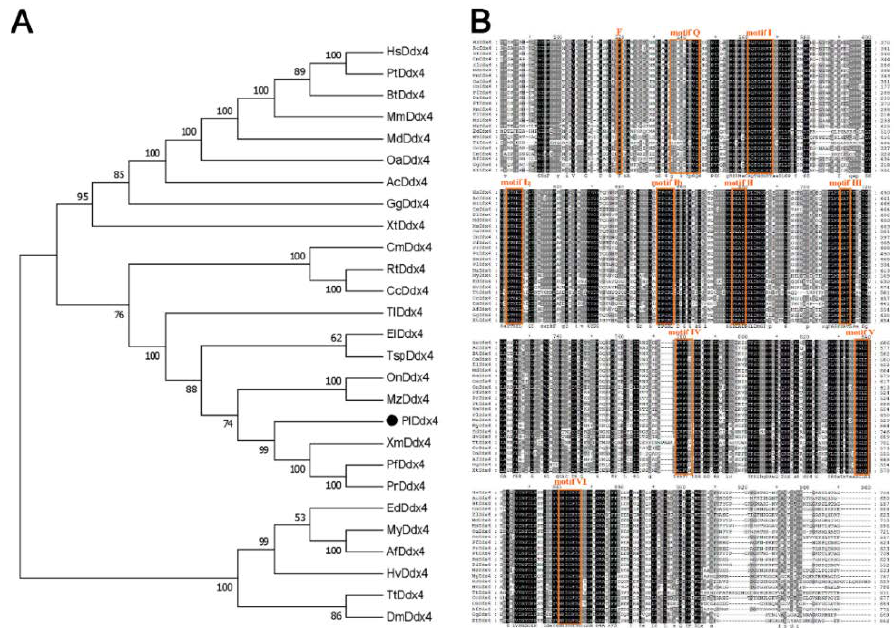
Figure 1. Sequence alignment and phylogenetic tree of vasa genes. ( A ) Phylogenetic tree of Vasa from leopard coral grouper and other species. The phylogenetic relationship of Vasa protein was inferred with the neighbor–joining method by MEGA7. All the assembly ID of vasa homologs can be found in Table S1 from NCBI, Ensemble, and UniProt. Mammals—HS: Homo sapiens ; Pt: Pan